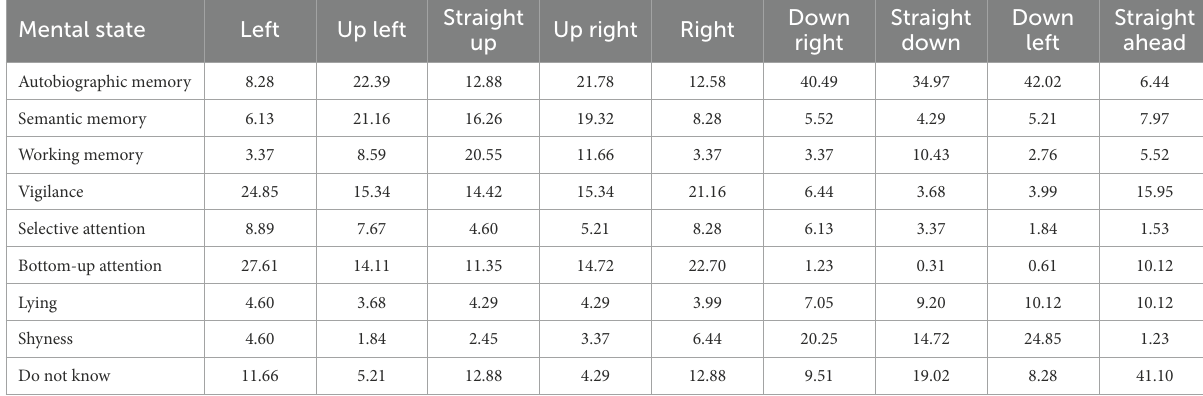
TABLE 4 Frequencies of responses (in %) during Experiment 2 for the condition with gaze at low eccentricity. Mental state Left Up left